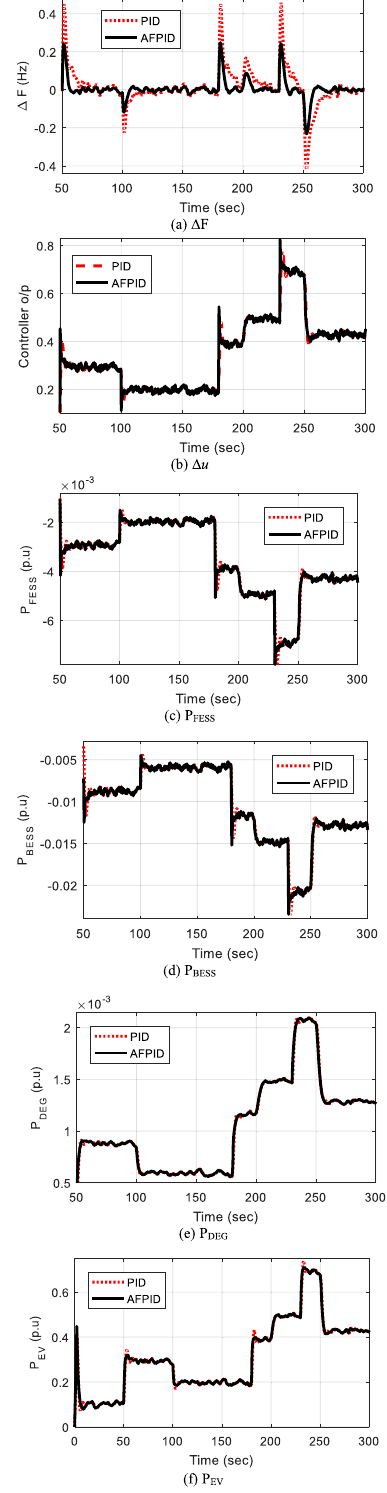
Fig. 10 System performance for case 1 a Δ F b Δ u c P FESS d P BESS e P DEG f P EV